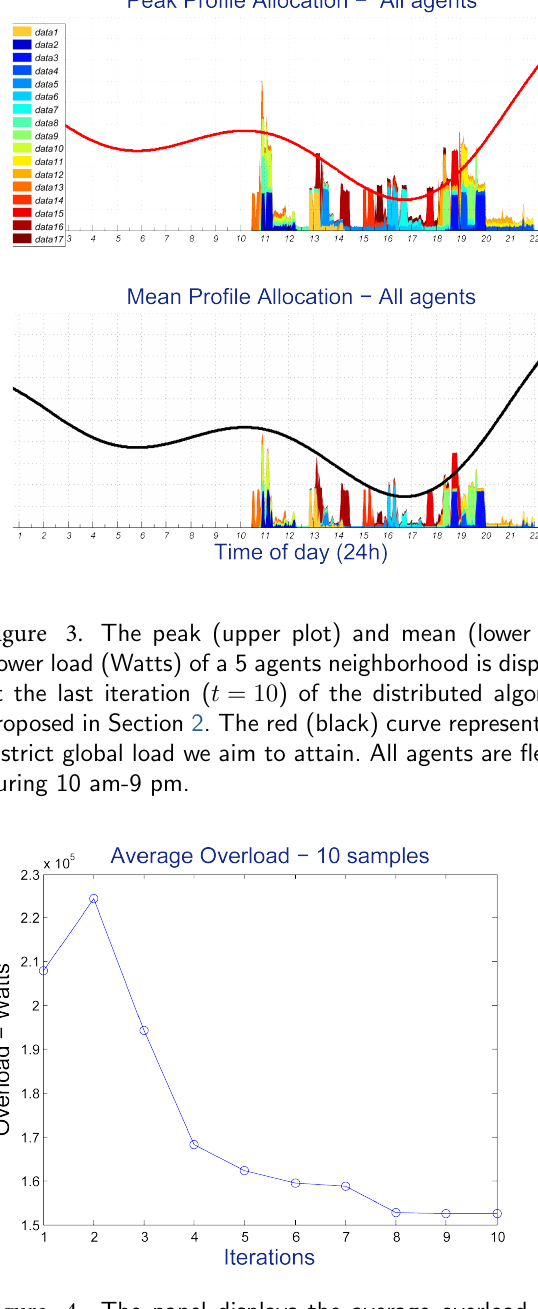
Figure 4. The panel displays the average overload